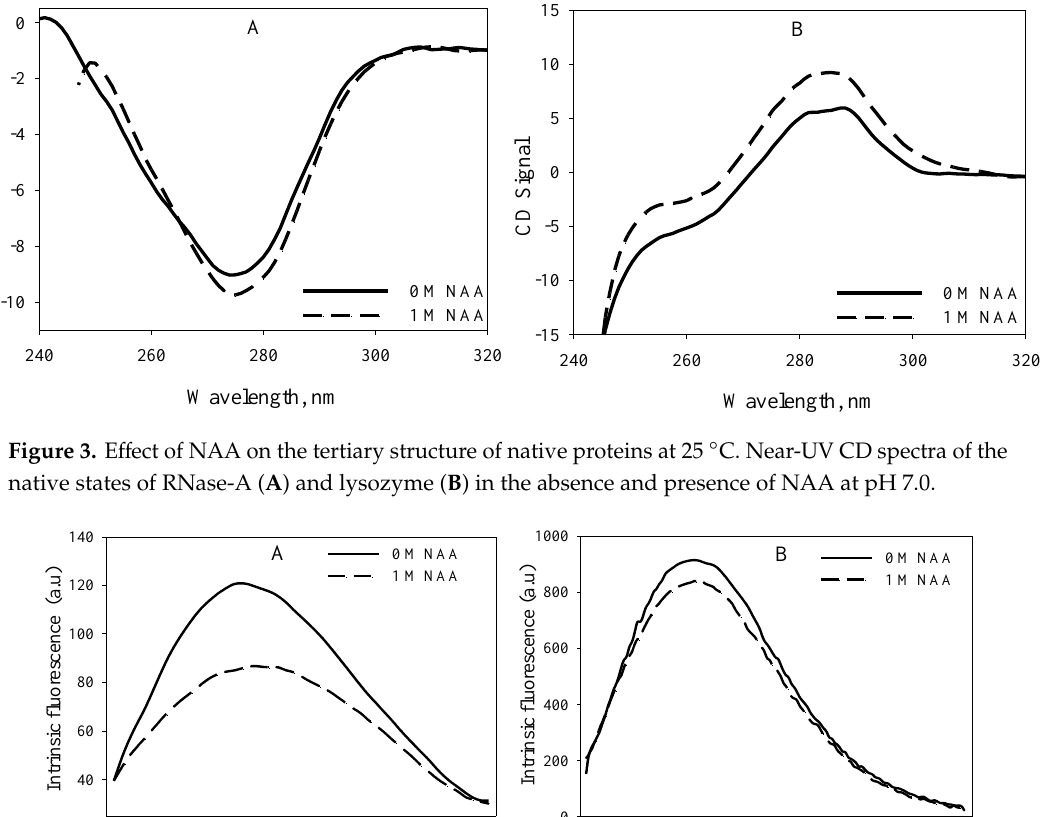
Figure 2. Thermal denaturation profiles of lysozyme at pH 7.0 and pH 2.5. Left panels: Denaturation curves of lysozyme at pH 7.0 ( A ) and at pH 2.5 ( B ) in the absence and presence of various NAA concentrations. Right panels: Plots of ∆ T m versus NAA of lysozyme at pH 7.0 ( C ) and at pH 2.5 ( D ).The protein concentration used was 58 µM.